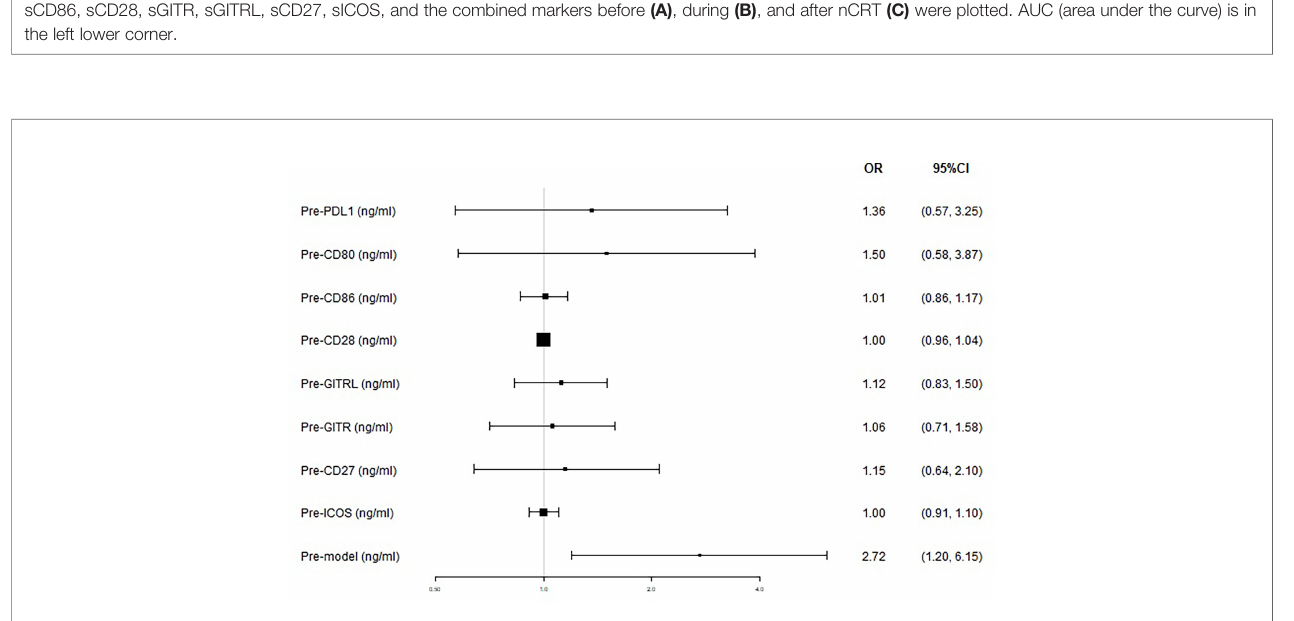
FIGURE 5 | Treatment response according to baseline plasma levels of immune checkpoints. The prognostic relevance of each marker was assessed using the univariate logistic regression model and presented in the form of forest plot.